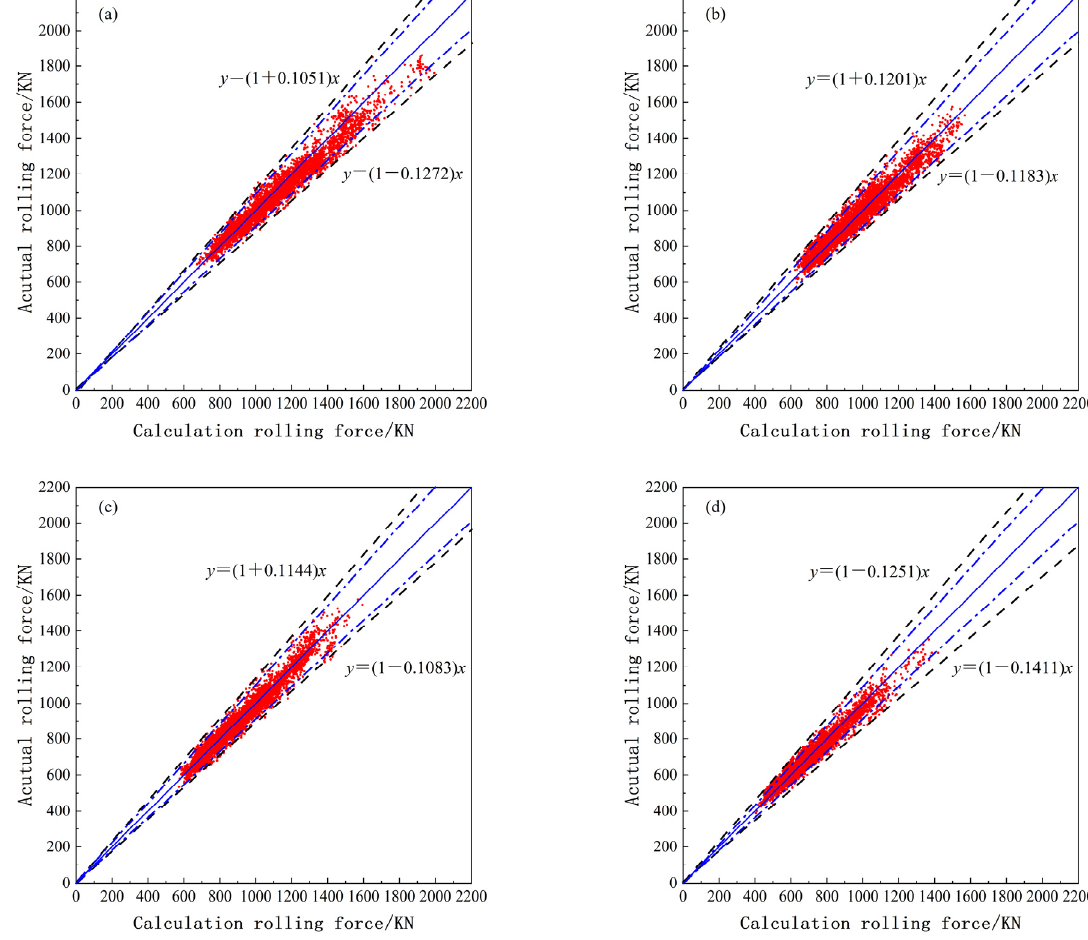
Figure 8. Rolling force calculation result distribution after the optimized deformation resistance model: ( a ) S1 stand, ( b ) S2 stand, ( c ) S3 stand, and ( d ) S4 stand.